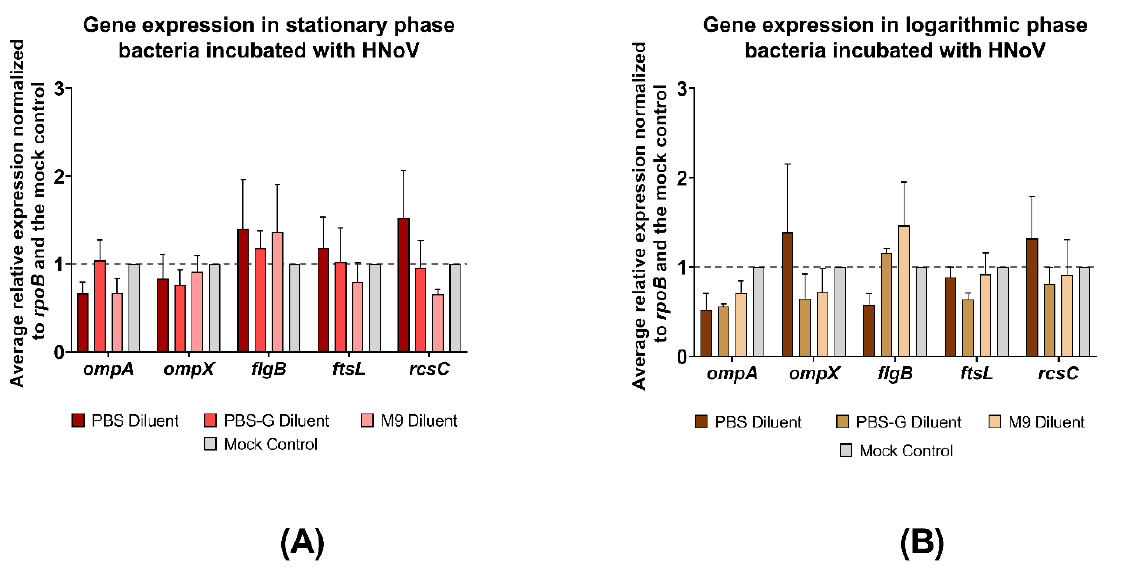
Figure 3. The bacterial growth phase and media do not significantly alter E. cloacae gene expression during HNoV binding. ( A ) Differences in gene expression measured via qPCR when HNoV interacts with E. cloacae at stationary growth phase; ( B ) differences in gene expression measured via qPCR when HNoV interacts with E. cloacae at mid-log growth phase. Relative expression and significance are measured against gene expression of a mock control of E. Cloacae without MNV, signified by a dashed line at y = 1 and the mock control column. Error bars show SEM; n = 3.